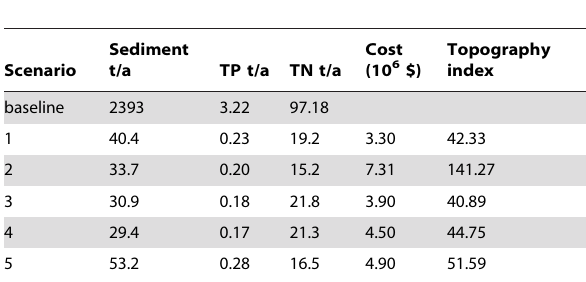
Table 8. The TAIOM NPS (Sediment, NPS-N and NPS-P) load obtained during the post-BMP